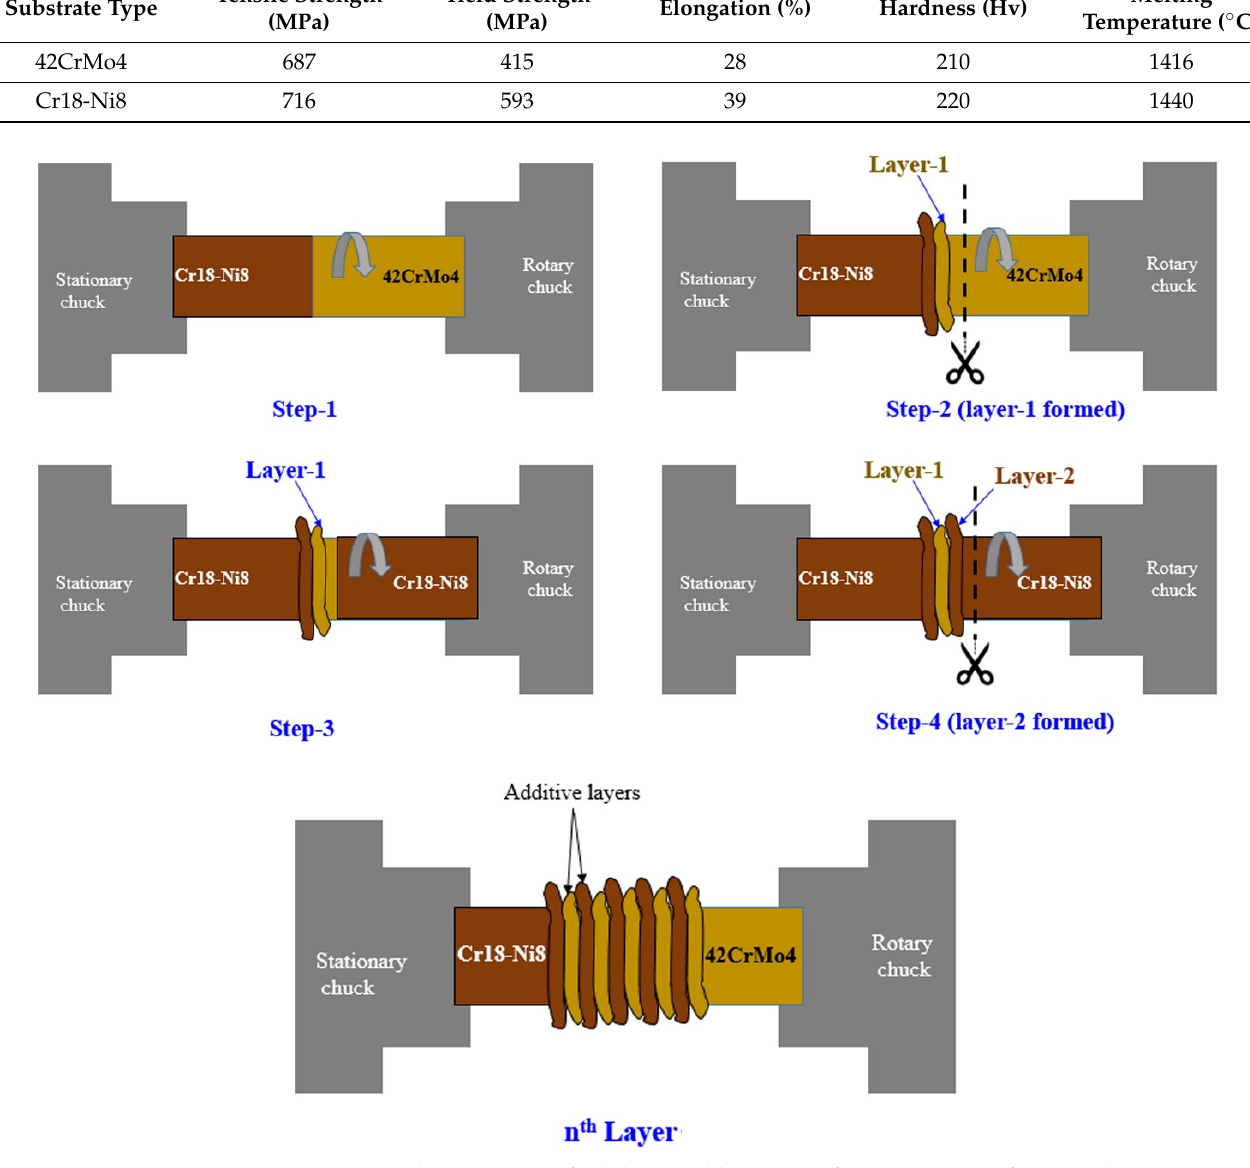
Figure 1. Schematic view of solid state additive manufacturing process for parts deposition.